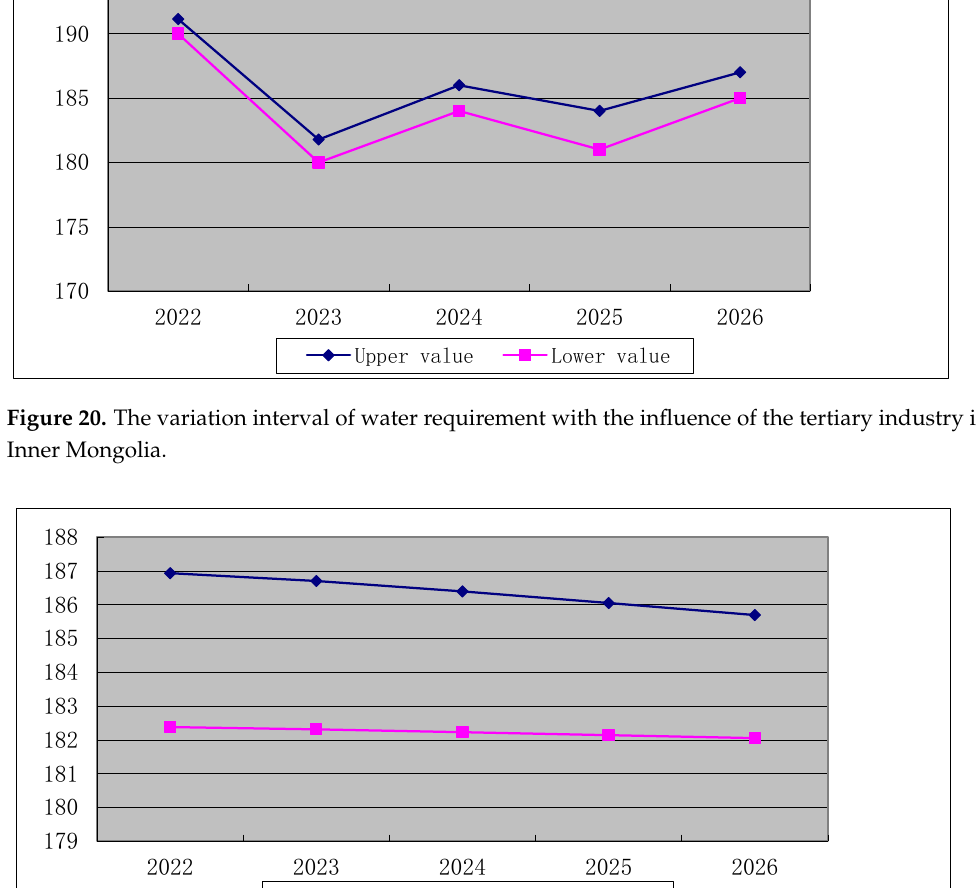
Figure 21. The variation interval of water requirement with the influence of population in Inner Mongolia.